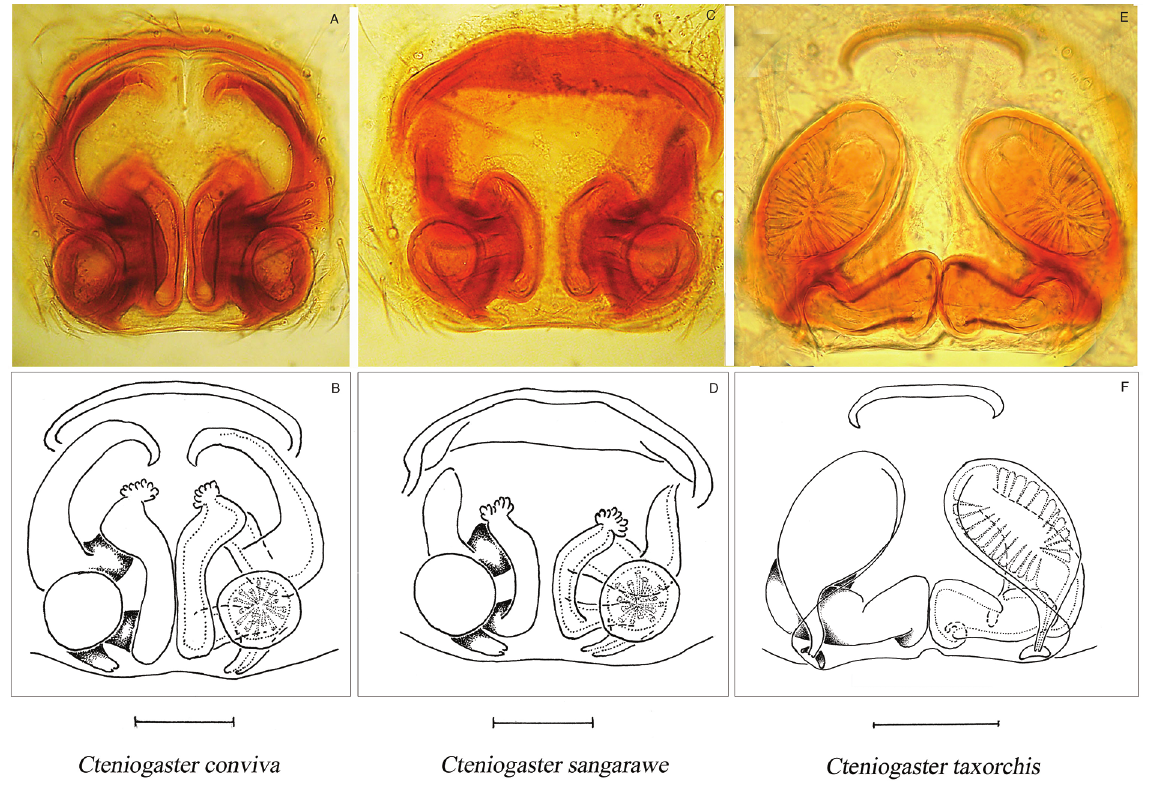
Fig. 5. Female genitalia, dorsal view. A, C, E: cleared in methyl salicylate. A-B. Cteniogaster